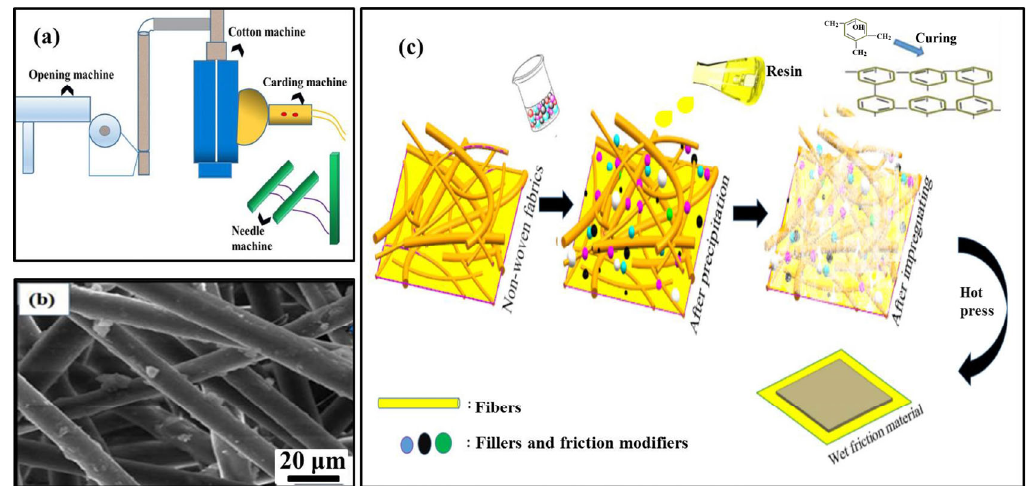
Fig. 1 (a) NWF manufacturing process, (b) the microstructure of NWF, and (c) schematic of overall fabrication process of the new kind of wet friction